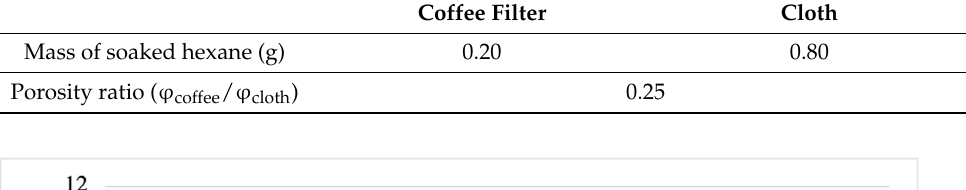
Figure 5. Contact angle of filters treated by different methods. Table 1. Porosity Ratio of Coffee Filter and Cloth Substrate. Table 1. Porosity Ratio of Coffee Filter and Cloth Substrate. Coffee Filter